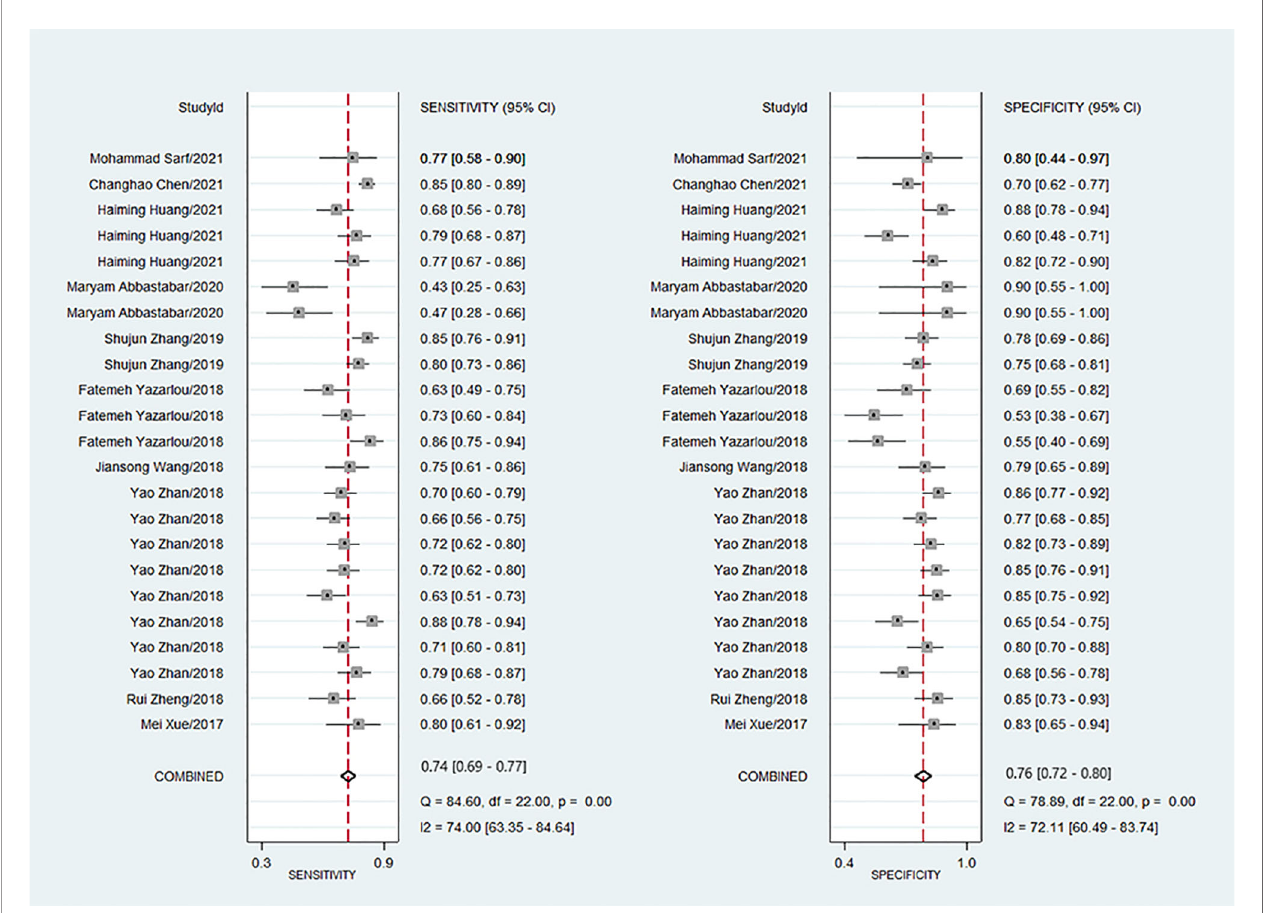
FIGURE 3 | Forest plots of sensitivity and speci fi city for exosome derived lncRNAs in the diagnosis of bladder cancer.